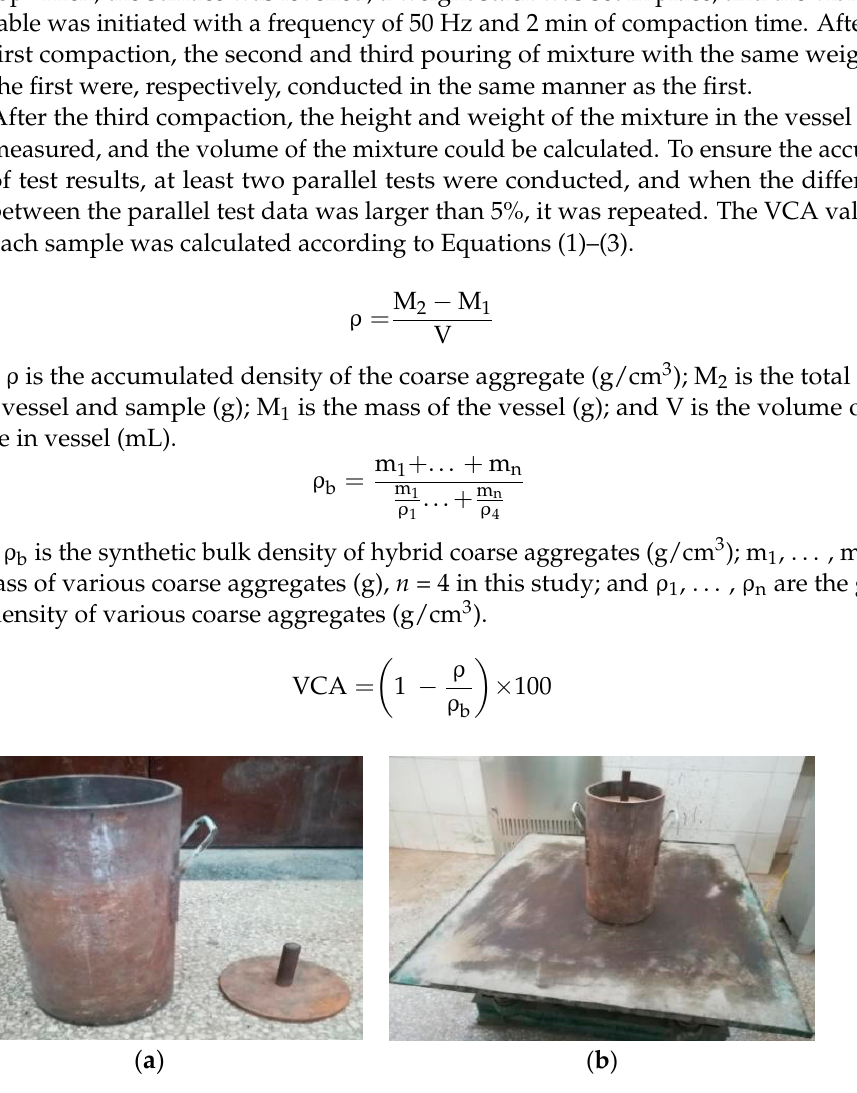
Figure 2. Vibrating vessel for the coarse aggregate and vibration device. ( a ) Vessel for filling the coarse aggregate. ( b ) Vibrating table.